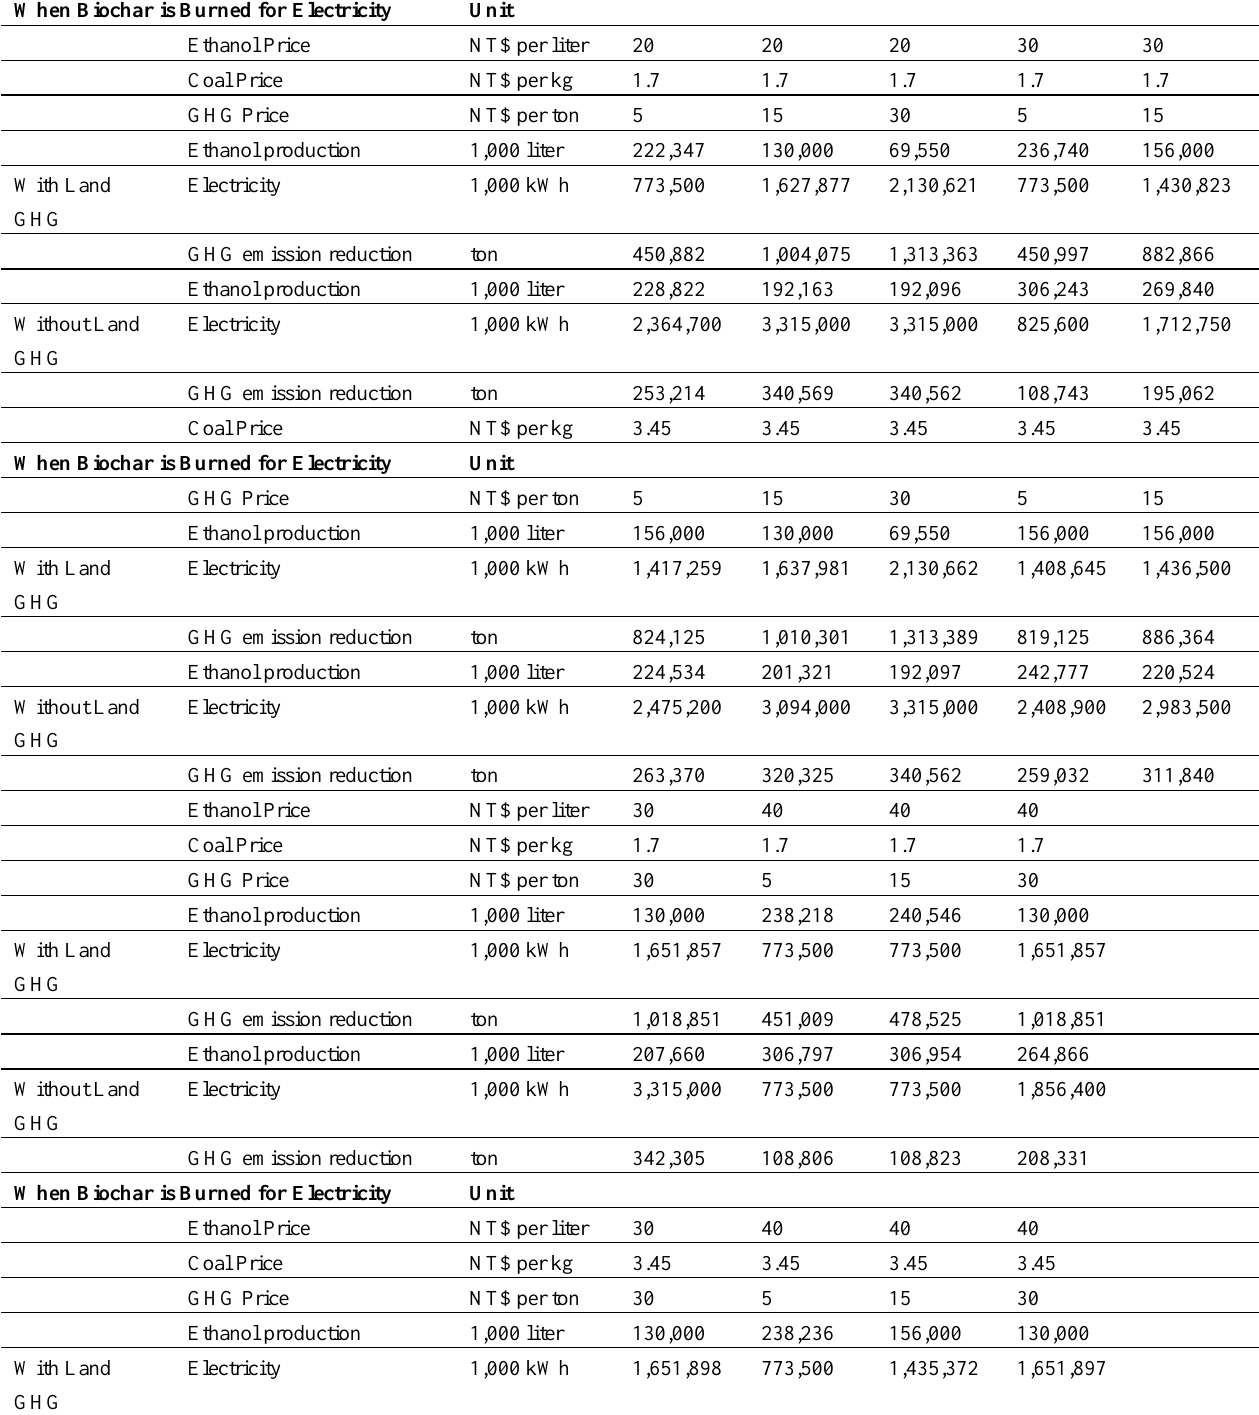
Table A1. Simulation results of bioenergy production and GHG emissions offset for with and without endogenous land GHG